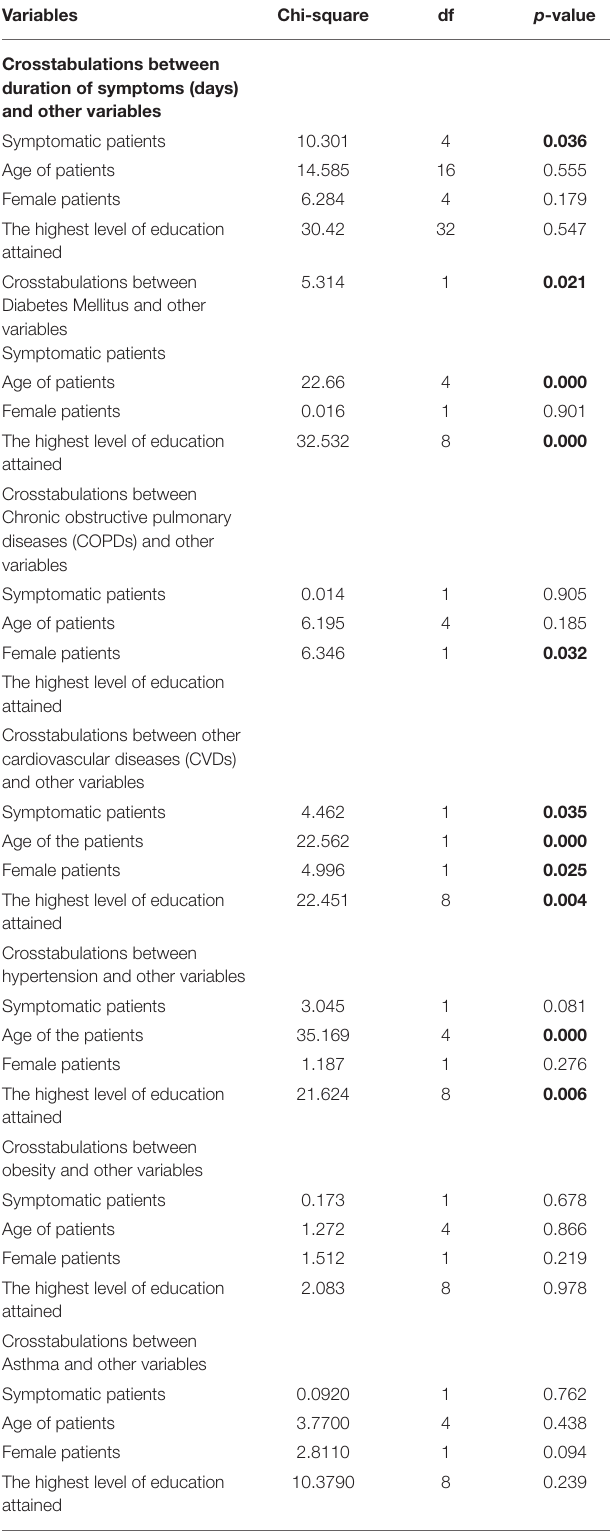
TABLE 4 | Crosstabulations on factors associated with female gender among the COVID-19 patients in Gulu Hospital. Variables